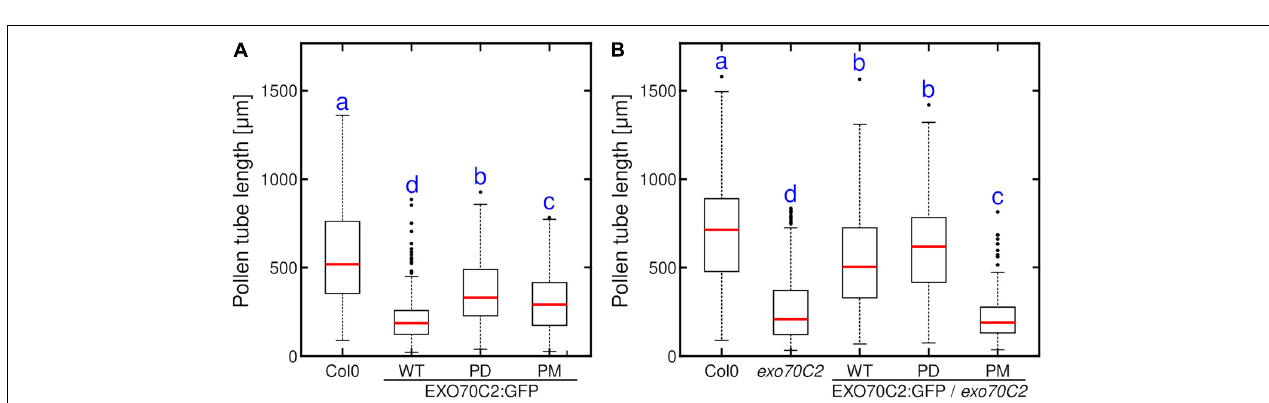
FIGURE 4 | Phosphorylation of EXO70C2 regulates its inhibitory function in tobacco pollen tubes. Quantitative analysis of growth rate (A) and thickness (B) in tobacco pollen transiently expressing 4 µ g of YFP:AtEXO70C2 wild type (WT), phospho-dead (PD) and phospho-mimetic (PM) variants. Pollen tubes expressing YFP:GUS and Arabidopsis YFP:EXO70A2 were used for comparison. Measurements were performed on 40 or more transformed pollen tubes per variant imaged during three independent experiments. Different letters indicate significant differences between samples at P < 0.05.